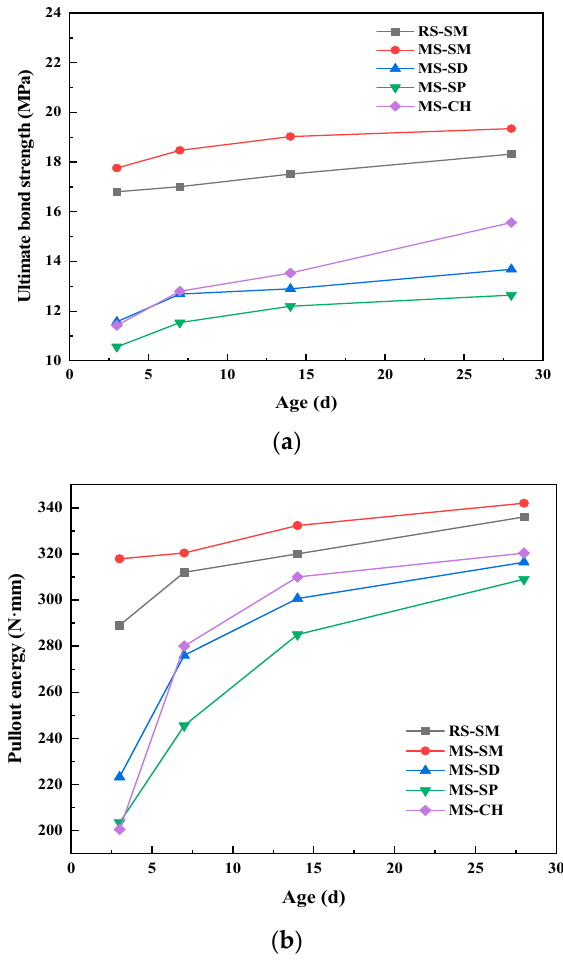
Figure 9. Bonding properties of manufactured sand UHPC at different ages under different curing methods. ( a ) Ultimate bond strength. ( b ) Pullout energy.